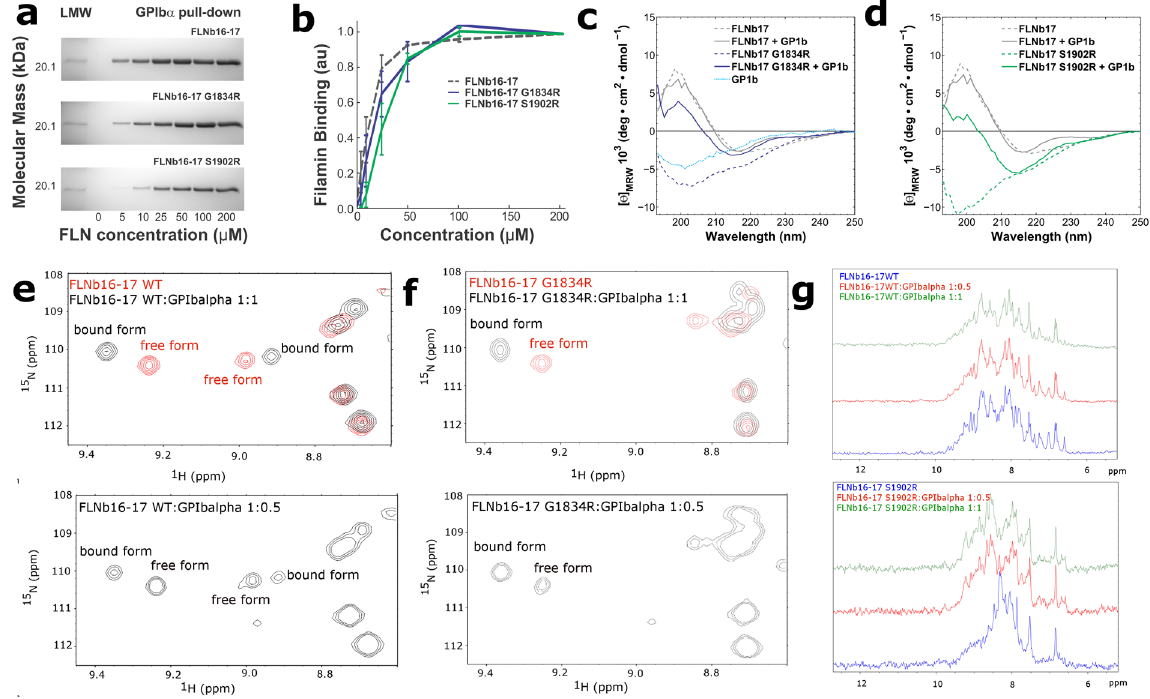
Figure 5. Effects of G1834R and S1902R mutations on FLNb16-17 interactions. ( a , b ) The binding assays show that FLNb16-17 G1834R and S1902R mutants are able to bind the GP1b α -peptide almost similar avidity as FLNb16-17 WT despite of the fact that these mutation unfold domain 17. GP1b α -peptide binding to FLNb16- 17 WT and G1834R and S1902R mutants in 5, 10, 25, 50, 100, and 200 μ M concentrations is shown. FLNb16- 17 WT and G1834R and S1902R mutants binding to GP1b α -peptide was quantified by protein staining and expressed as FLN binding (in arbitrary units) calculated as the ratio of FLN bound to FLN in the loading control, normalized to maximal FLN binding in each experiment (mean S.E. (error bars); n ≥ 3). ( c , d ) The CD- spectrometry measurements show that the GP1b α -peptide binding to G1834R ( c ) and S1902R ( d ) mutated FLNb17 induces β -sheet folding on these domains. ( e , f ) Selected regions of HSQC spectra of 15 N-labelled FLNb16-17 WT and G1834R fragments collected before and after titration with GP1b α -peptide shows tight binding of the peptide to both WT ( e ) and G1834R ( f ) fragments. ( g ) One-dimensional 15 N-edited, 1 H spectra of FLNb16-17 WT and S1902R with increasing concentration of GPIb α peptide. Spectra for S1902R mutant highlight increasing dispersion of amide proton chemical shifts upon titration of GPIb α -peptide, indicative of growing structural